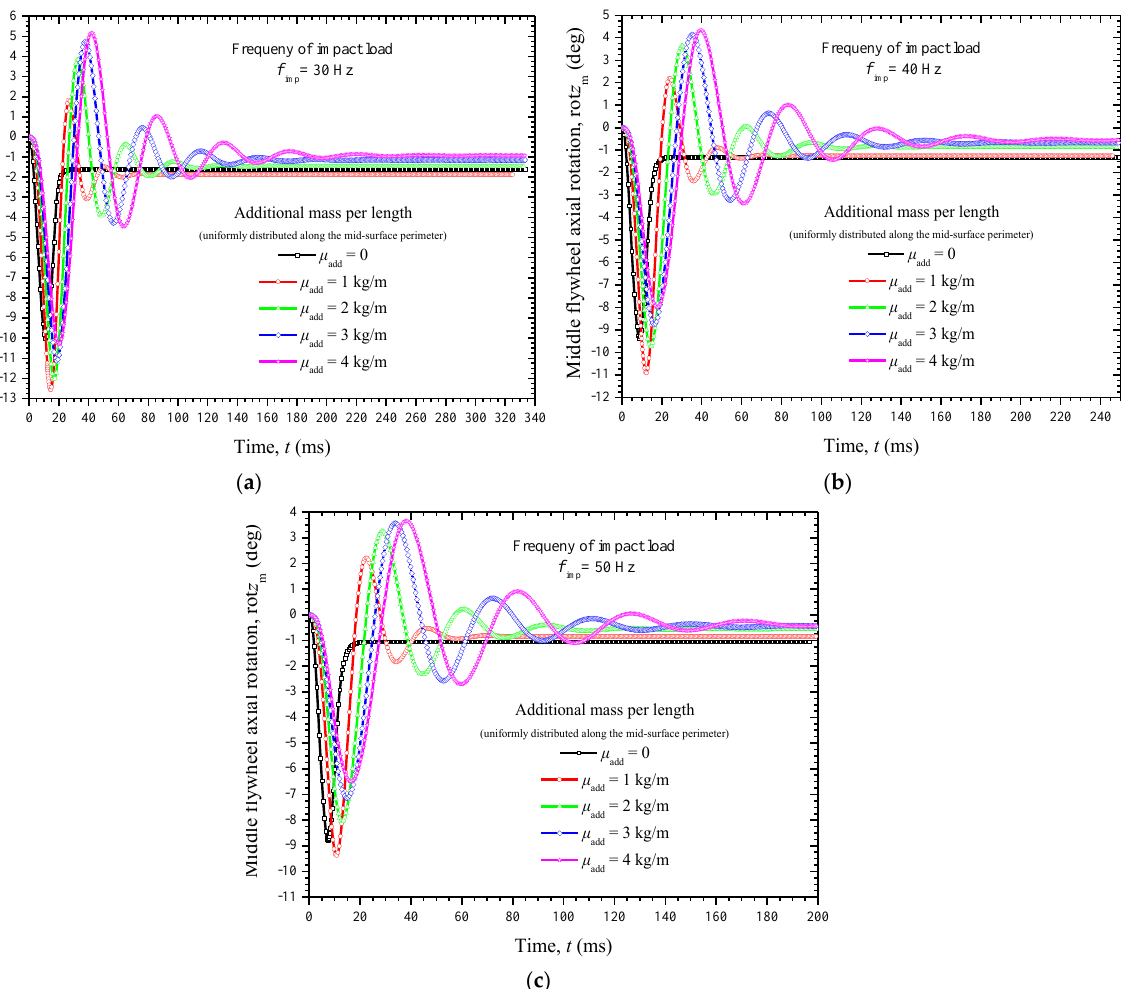
Figure 12. Time variation of the middle flywheel axial rotation under a half − sine impact shock characterized by a frequency of ( a ) 30 Hz, ( b ) 40 Hz, and ( c ) 50 Hz, for a variety of mass additions around the flywheel perimeter.